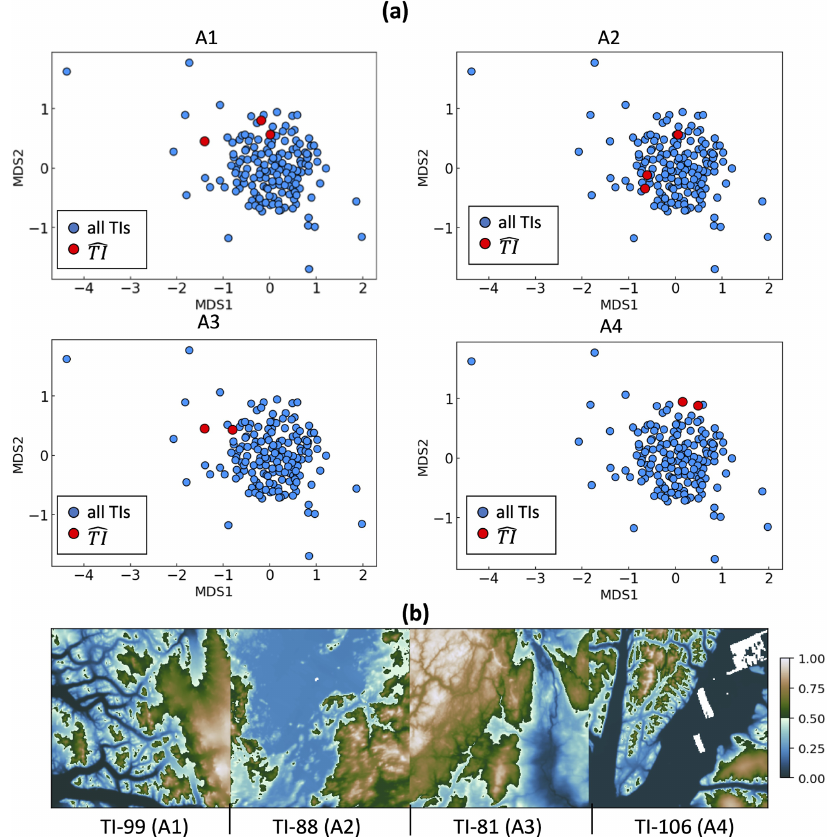
Figure 8. (a) The estimated set of most probable training images (cid:98) TI on MDS plots for each subarea (A1, A2, A3, A4). The red dots highlight the estimated (cid:98) TI. (b) Examples of (cid:98) TI displayed in the topographic modelling space.